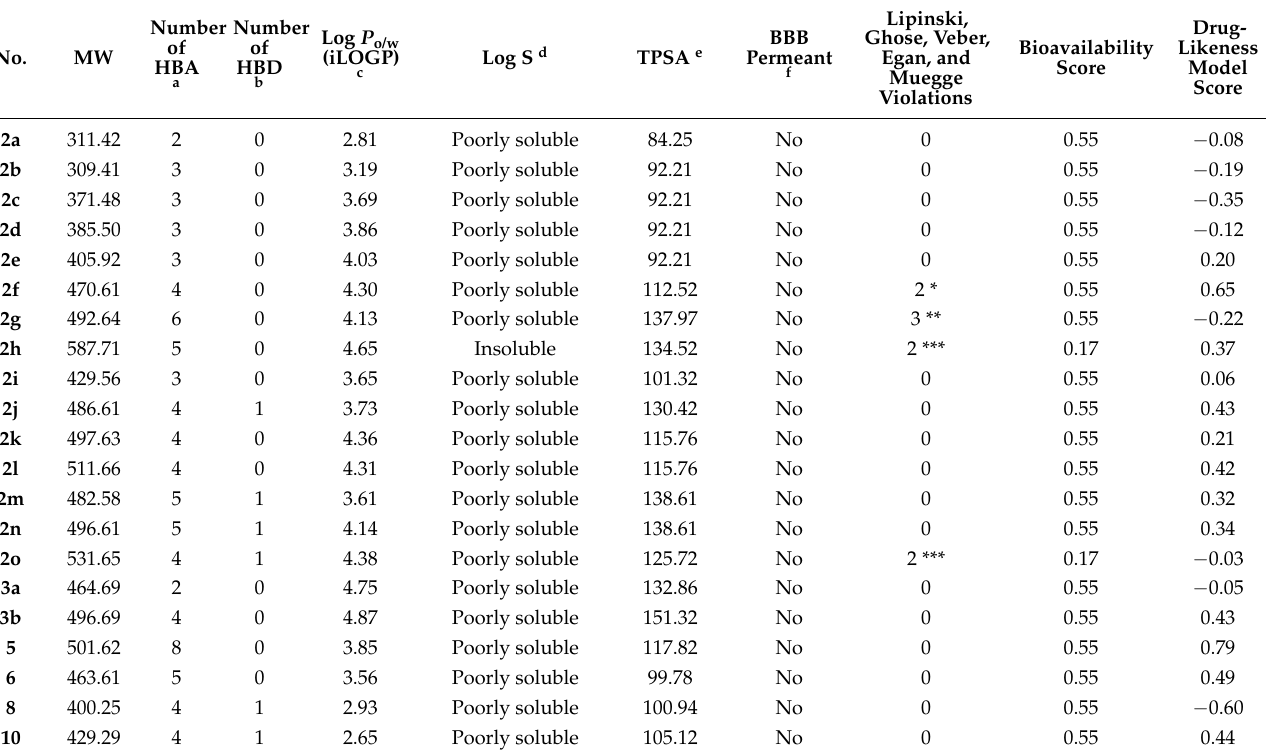
Table 5. Drug likeness predictions of tested compounds.